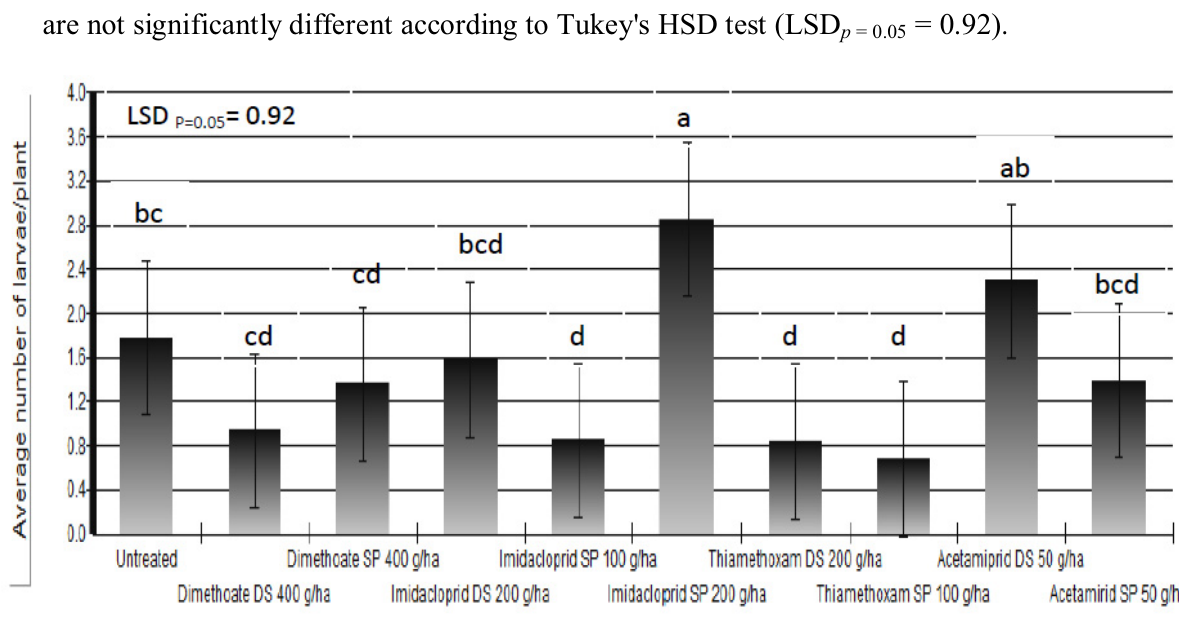
Figure 6. Average number of Delia radicum (L.) larvae/plant following different insecticide treatments (DS = dipping of the seedlings into insecticide solution before transplanting; SP = spraying) over three field seasons (means followed by the same letter are not significantly different according to Tukey's HSD test (LSD